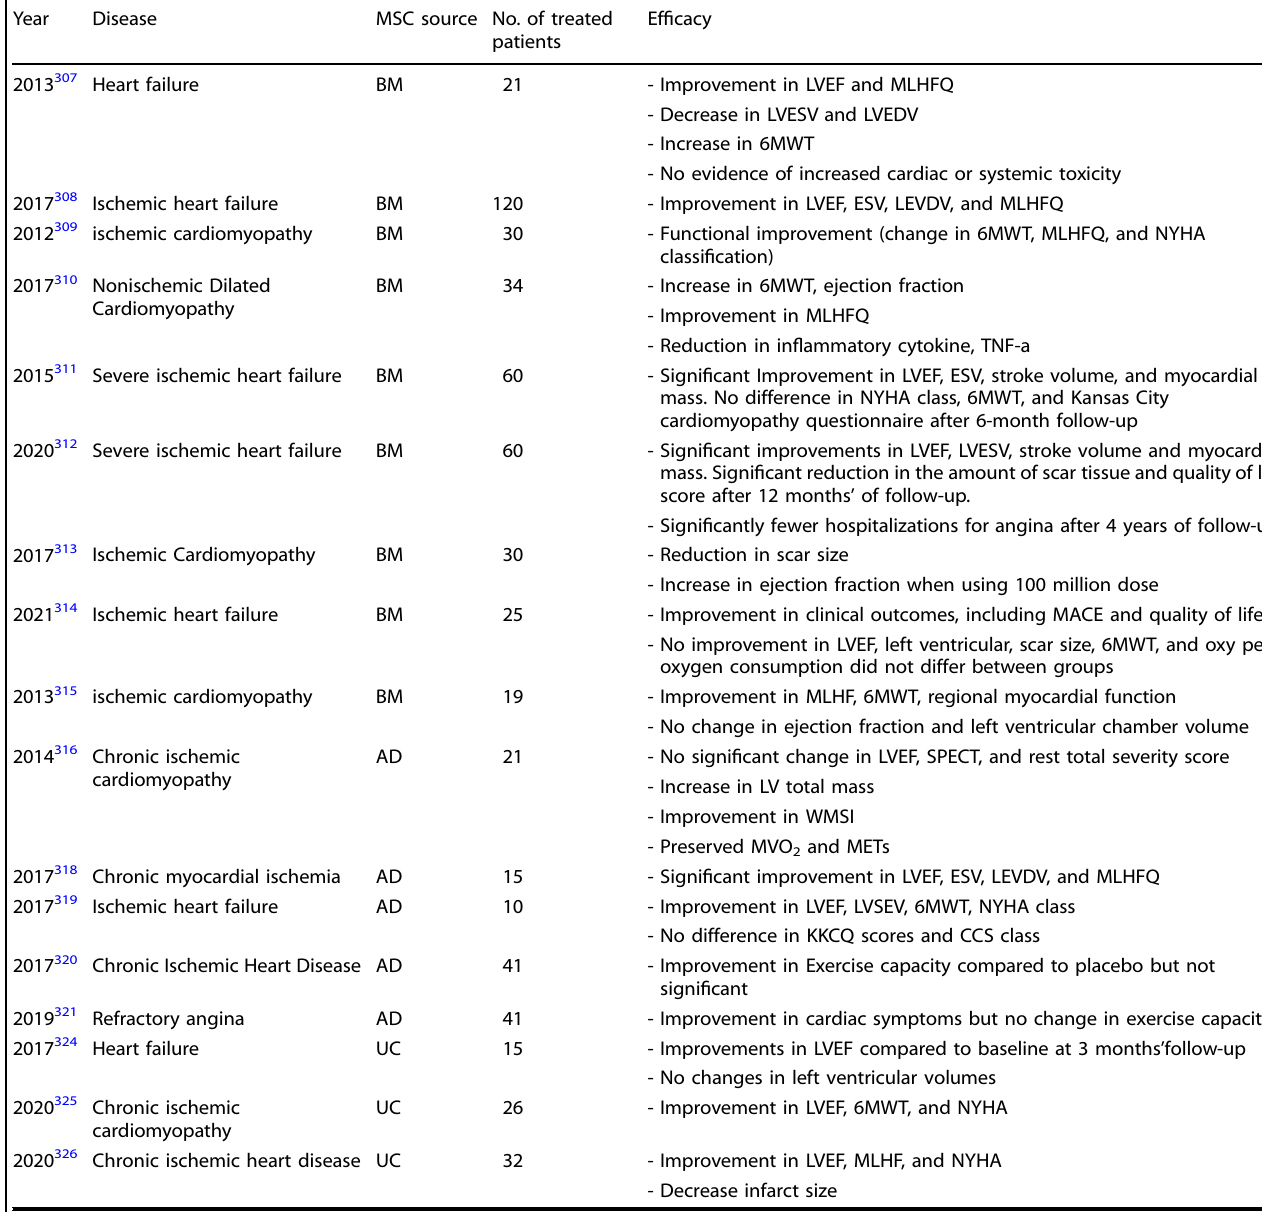
Table 4. The reported clinical trials using MSCs from AT, BM, and UC in the treatment of cardiovascular diseases Year Disease MSC source No. of treated